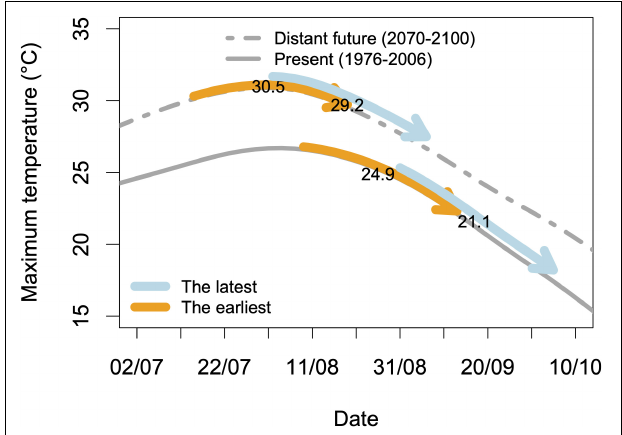
FIGURE 3 | Simulations of maximum temperatures during the ripening period for two virtual extreme genotypes and two climatic datasets. The arrows represent the ripening periods, i.e., 35 days starting at 50% véraison, for two virtual genotypes: the earliest and the latest that should be found in an infinite progeny from a Riesling × Gewurztraminer cross. Two climatic datasets are used: historical data from 1976 to 2006 and simulated data (A1B scenario) for Colmar (48 ◦ 04 (cid:48) 46.3 (cid:48)(cid:48) N 7 ◦ 21 (cid:48) 26.0 (cid:48)(cid:48) E). Details in Duchêne et al. (2010). The figures are the mean values of maximum temperatures during these